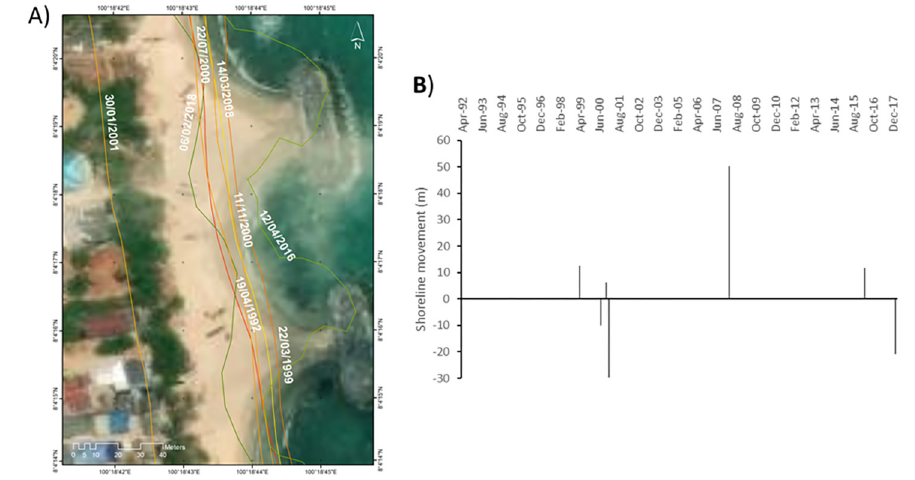
Fig 6. Representations of the shoreline movements observed during the survey period in site 1. A) Visualisation of the shoreline positions for the highest water level marks digitised with CoastSat. B) Shoreline movements measured using DSAS between two consecutives chronologically ordered digitised shorelines; negative values correspond to erosion and positive values to accretion. Basemap satellite images accessed from World Imagery ESRI Tile Layer. Credits: Esri, Maxar, GeoEye, Earthstar Geographics, CNES/Airbus DS, USDA, USGS, AeroGRID, IGN, and the GIS User Community.